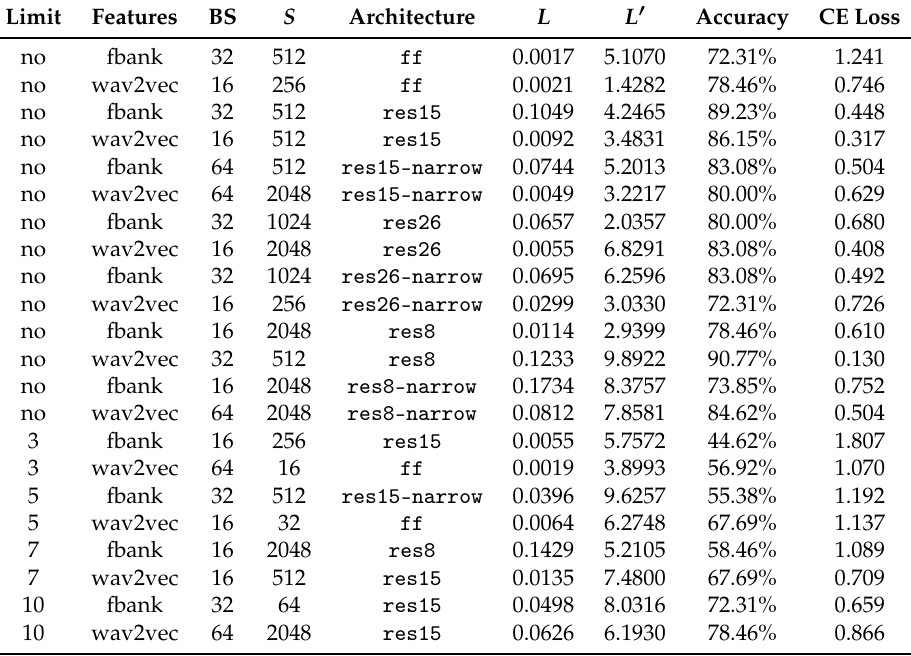
Table A3. Test metrics and hyperparameters on the Lithuanian dataset